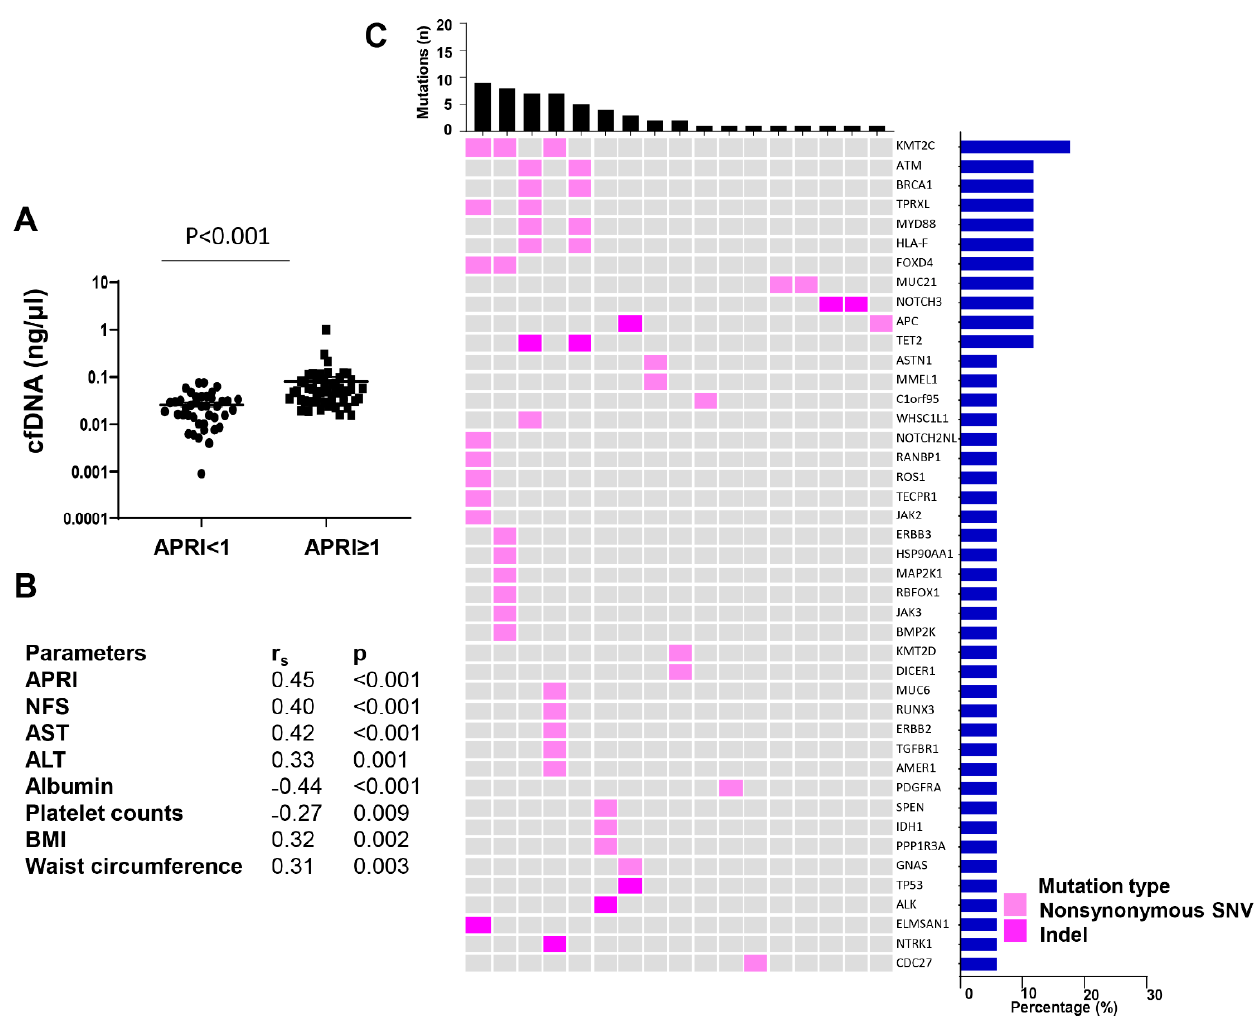
Figure 3. Mutations identified in cfDNA from Hispanic patients with advanced fibrosis/cirrhosis. ( A ) cfDNA concentration in plasma of subjects with APRI < 1 and APRI ≥ 1. ( B ) Clinical parameters of all CCHC subjects. ( C ) Genomic landscape of cfDNA from patients with advanced fibrosis/cirrhosis. Heatmap illustrating nonsynonymous mutations detected in plasma. The upper bar charts represent the number of mutations in each patient. The right bars show the frequencies of specific altered genes in the total cohort. Data are presented as mean ± SEM. APRI, Aspartate transaminase to Platelet Ratio Index; Rs, spearman correlation coefficient; NFS, NAFLD Fibrosis Score; AST, aspartate transaminase; ALT, alanine transaminase; BMI, body mass index.